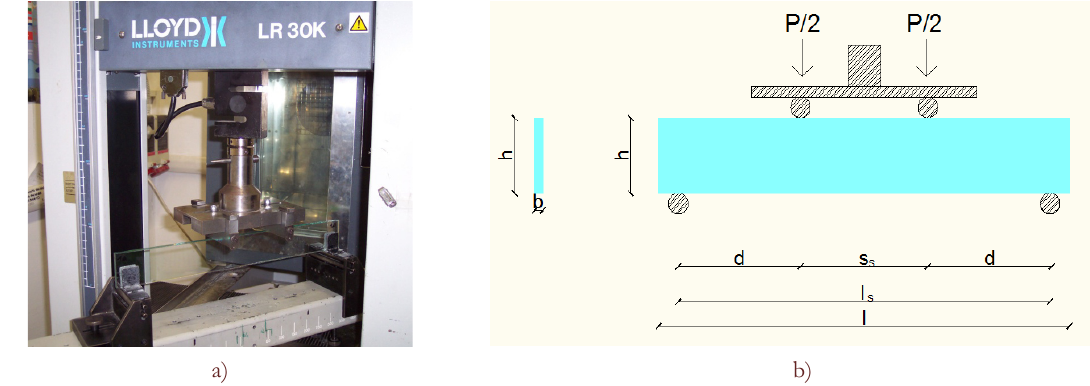
Figure 1: Test set-up used for in-plane four point bending tests (for each sample).